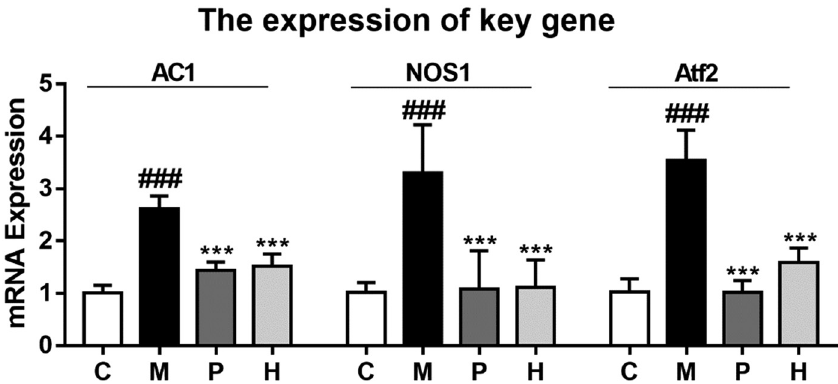
Figure A1: Expression of AC1 mRNA, NOS1 and Atf2 - mRNA in di ff erent groups. C, control; M, model; P, positive; H, the high - dose of SNX ( H ) .